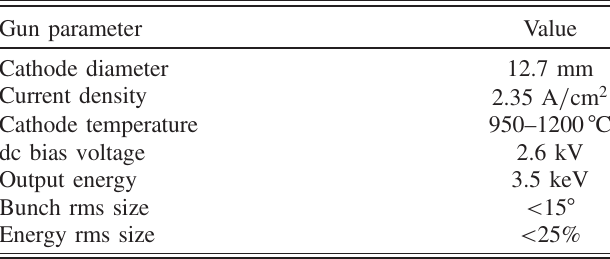
TABLE I. Parameters of the 650 MHz rf gun with thermionic cathode.